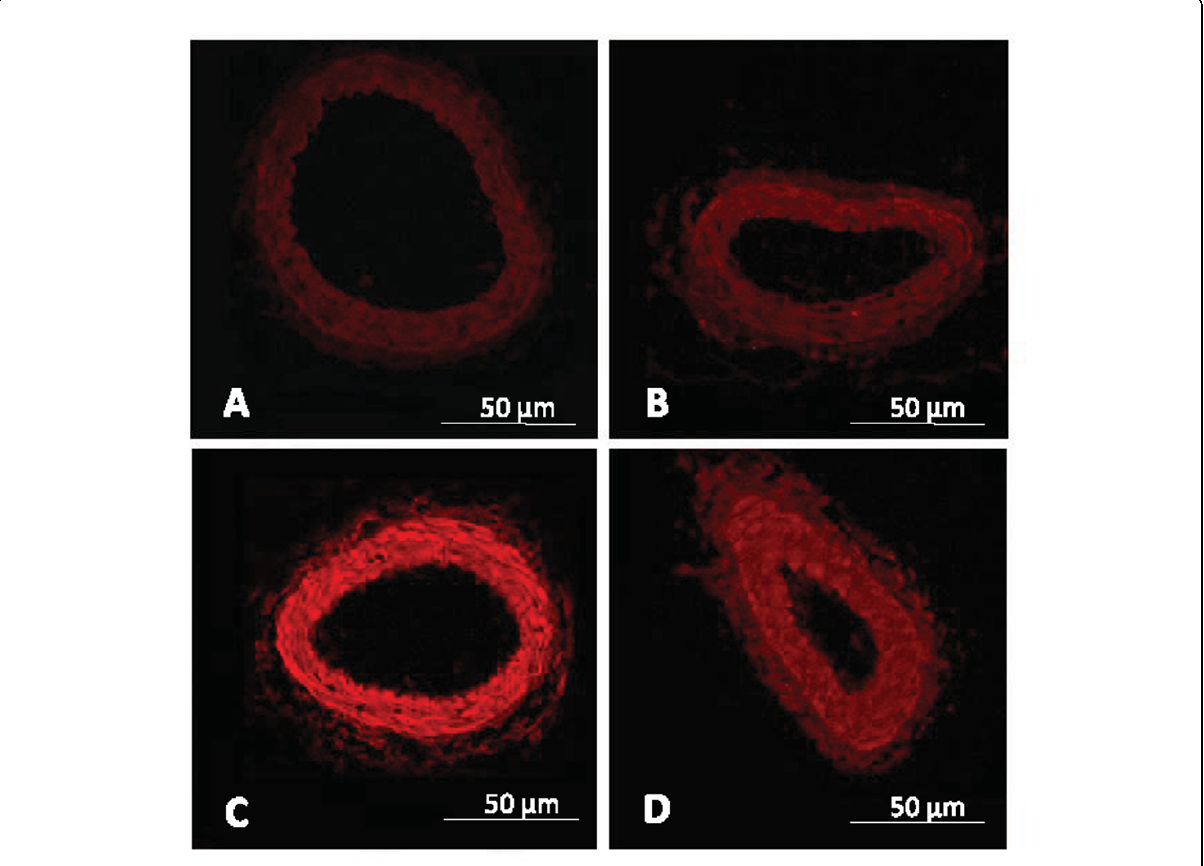
Figure 5 Immunofluorescent staining for PKC- b II . PKC- b II and TRITC signals from immunofluorescent staining of mesenteric arteries. Microvessels with diameter of approximately 100 μ m were fixed in 4% paraformaldehyde for 24 hours and then embedded in paraffin. They were later deparaffinized in xylene and rehydrated in a mixture of ethanol and distilled water. Antigens were unmasked using sodium citrate (10 mmol/L, pH 6.0), followed by exposure to a microwave heat source. Samples were then incubated at room temperature for 60 minutes with anti-PKC- b II at 1:100. Sections were washed in PBS and incubated with swine anti-rabbit IgG-TRITC (1:50 in PBS) for 30 minutes at room temperature. Immunofluorescent staining of small mesenteric arteries displayed a strong signal for PKC- b II in DM rats (Figure 5C). In contrast, the TRITC signals of anti-PKC- b II antibodies were weak in the controls and DM+cur rat vessels (Figure 5 B and D, respectively). The negative control displayed a minimal detectable fluorescence when the secondary antibodies were used alone (Figure